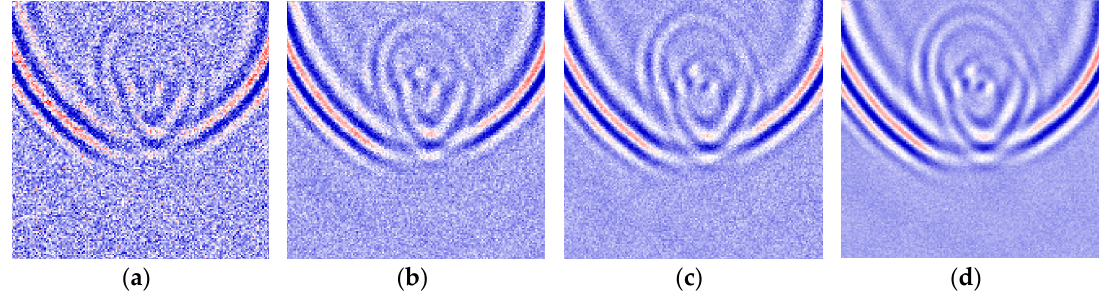
Figure 6. Effects of the averaging times on the ultrasonic images at 55 µ s for carbon fiber reinforced polymer (CFRP) quasi-isotropic laminate. ( a ) non-averaged; ( b ) 5 times; ( c ) 10 times; ( d ) 30 times.